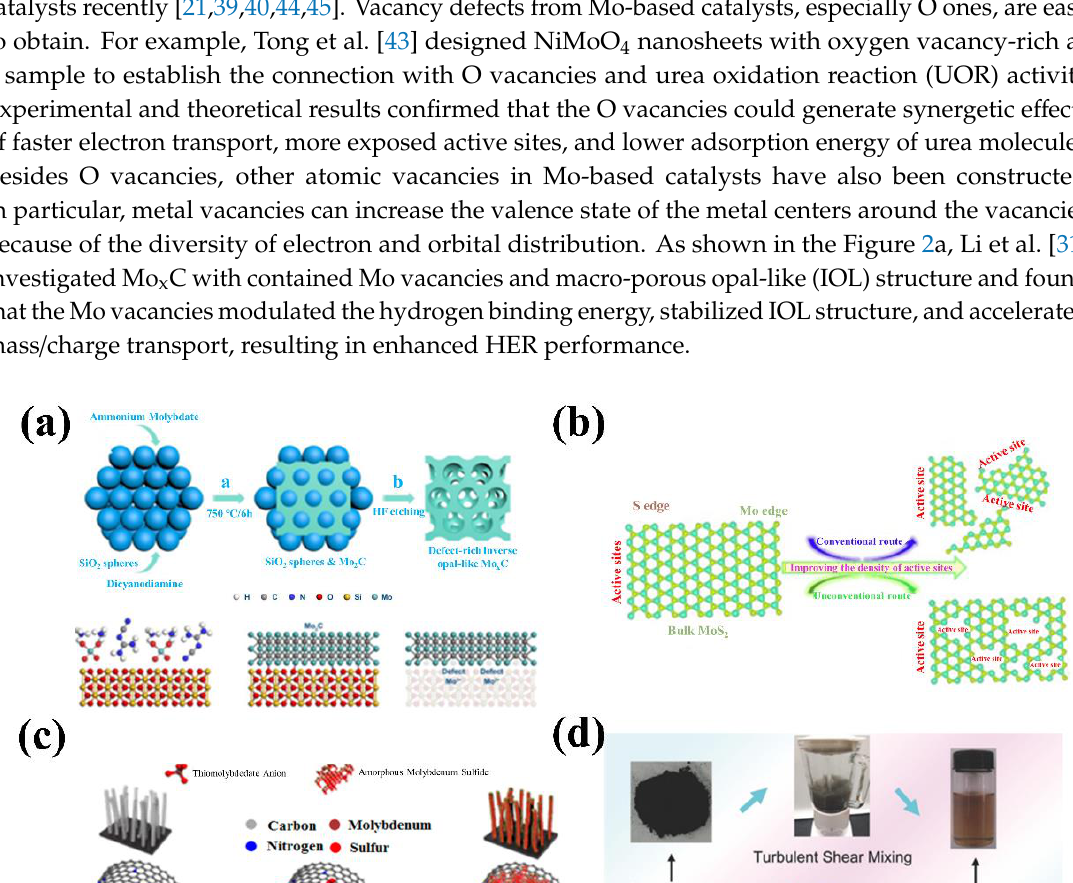
Figure 1. ( a ) schematic illustration for fabricating N-MoP/CC. Copyright 2020 Elsevier. ( b ) schematic illustration of hydrogen evolution catalyzed by palladium-doped MoS 2 anchored on vertical grapheme. Copyright 2020 Elsevier.